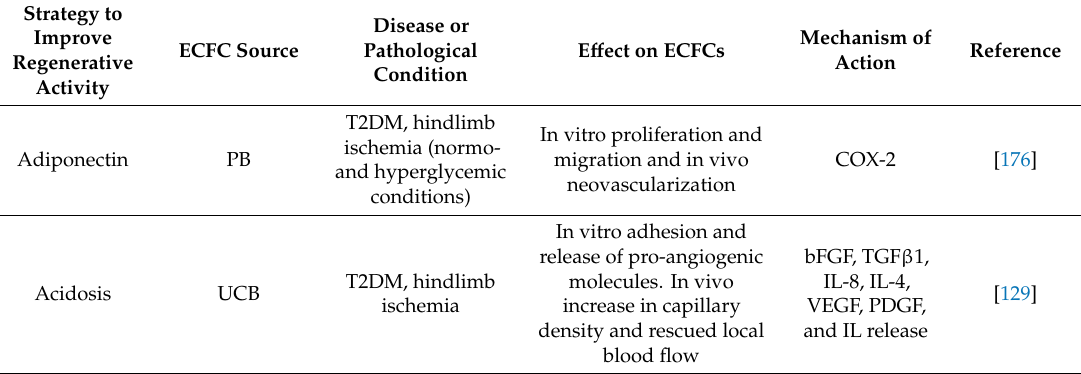
Table 3. Strategies to restore angiogenic activity of dysfunctional